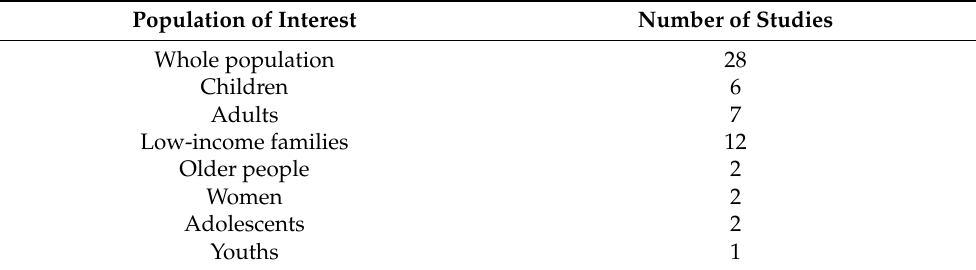
Table 3. Population of interest in selected publications. Population of Interest